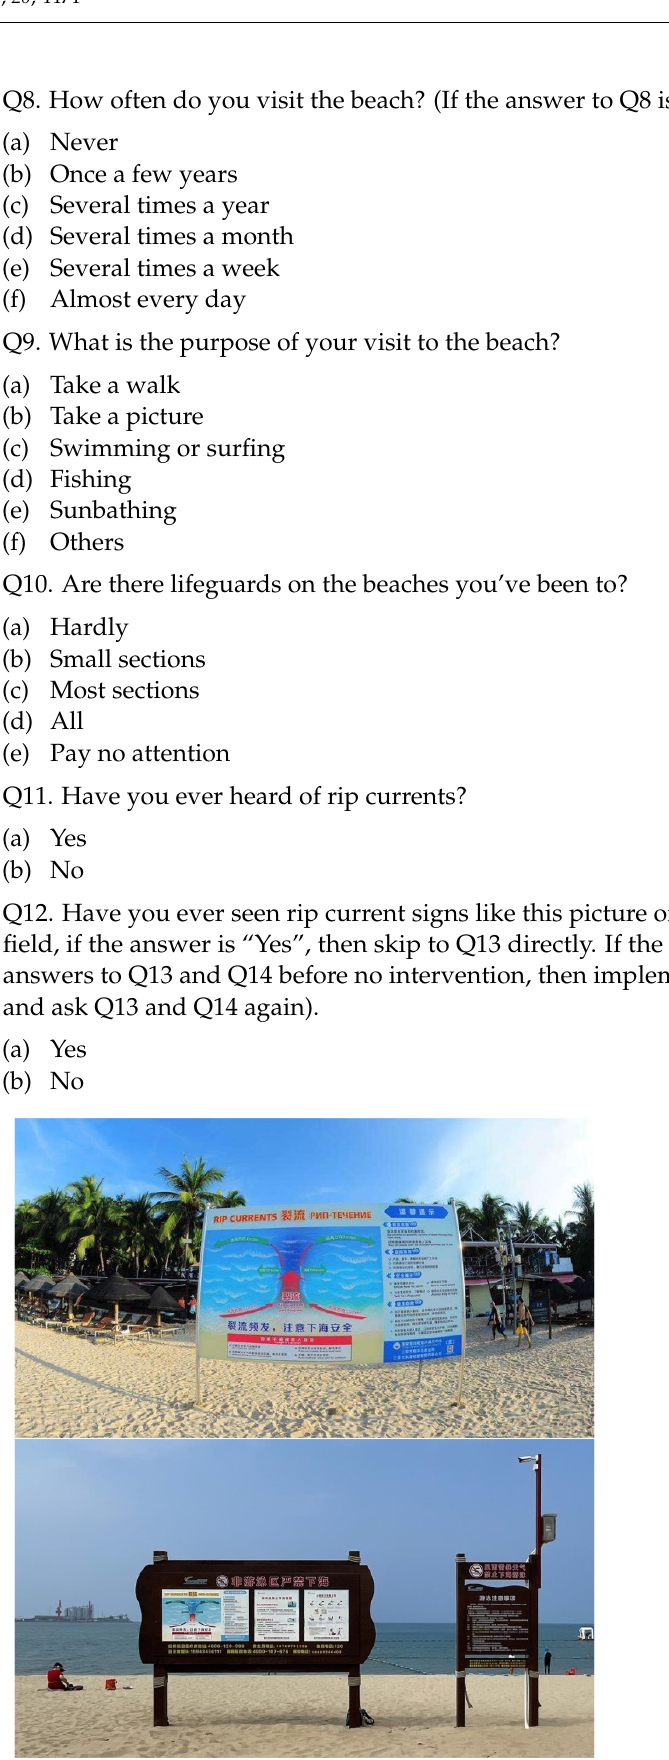
Figure A1. Some rip current warning signs on the beach in Sanya, China.